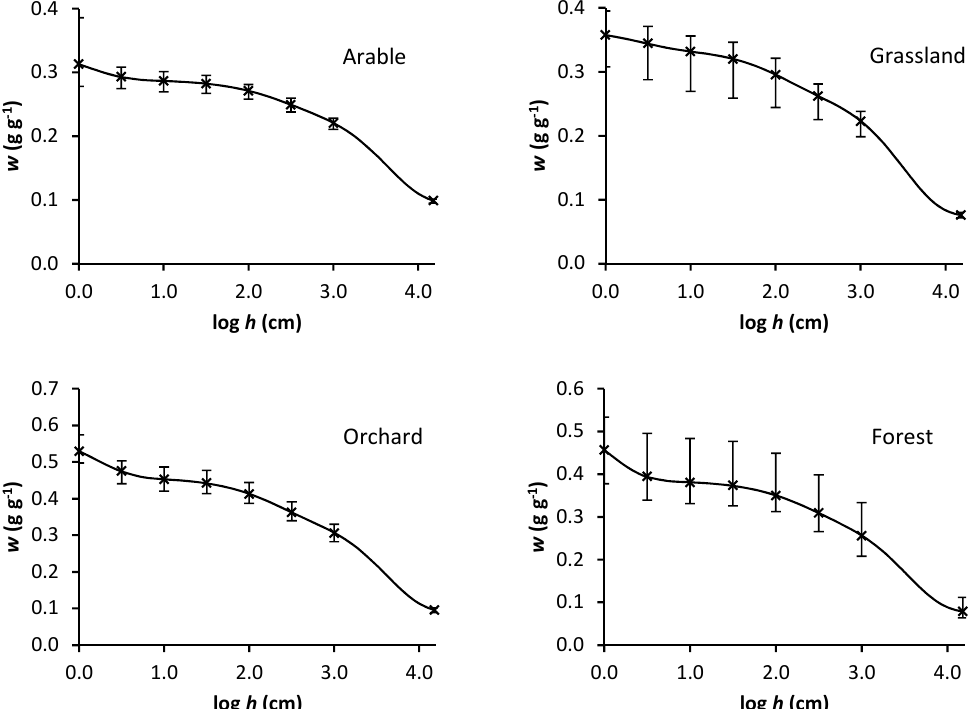
Figure 2. The soil water retention curves (SWRCs) determined in soils from the four research plots. The mean, maximum, and minimum measured values are presented as points with whiskers. The curves represent the best fitting triple-exponential model.